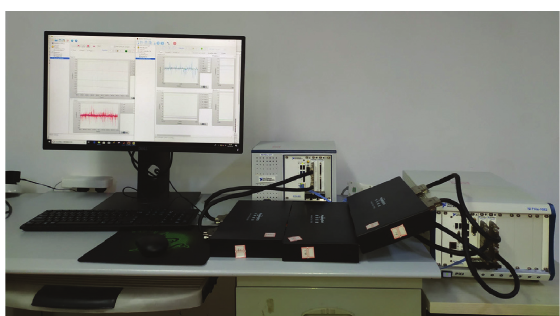
Figure 3: Actual experimental